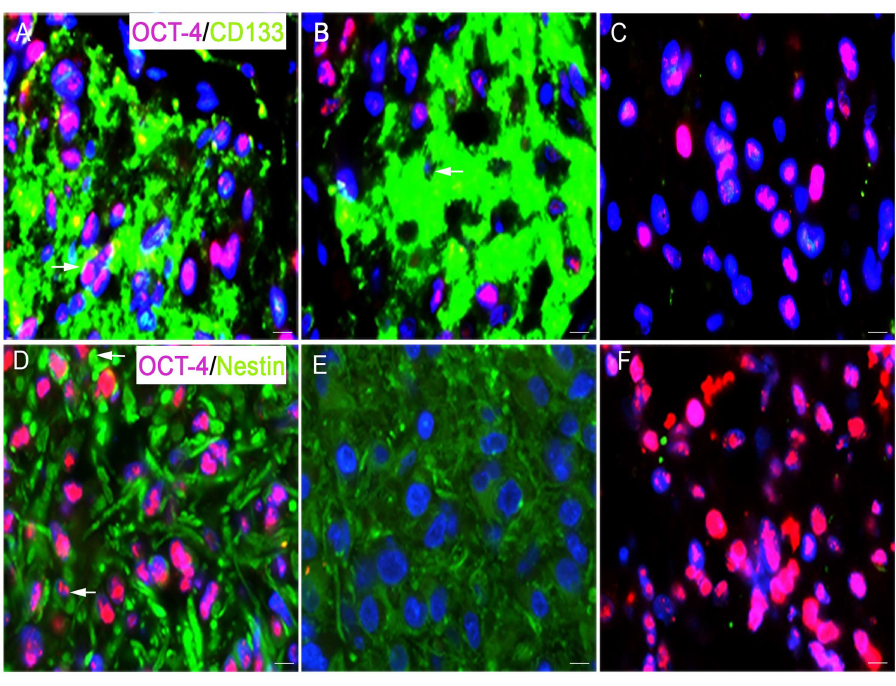
Fig 5. Double immunofluorescencestaining with Oct-4 and the TSC markersCD133and nestin. (A, B) The staining showedthat CD133positive (green) perivascular niches were found with both high (A, arrow) and low (B, arrow) Oct-4 (red) expressionlevels. (C) Areas were also found with Oct-4 positive dispersed singlecells without CD133 staining.(D, E) When Oct-4 (red) was combinedwith nestin (green), Oct-4 and nestin were found to be co-expressed in some areas (D, arrows), but areas were also identifiedwith only nestin positive cells (E) or only Oct-4 positive cells (F). Nuclei were counterstained with DAPI (blue). Scale bar indicates50 μ m,